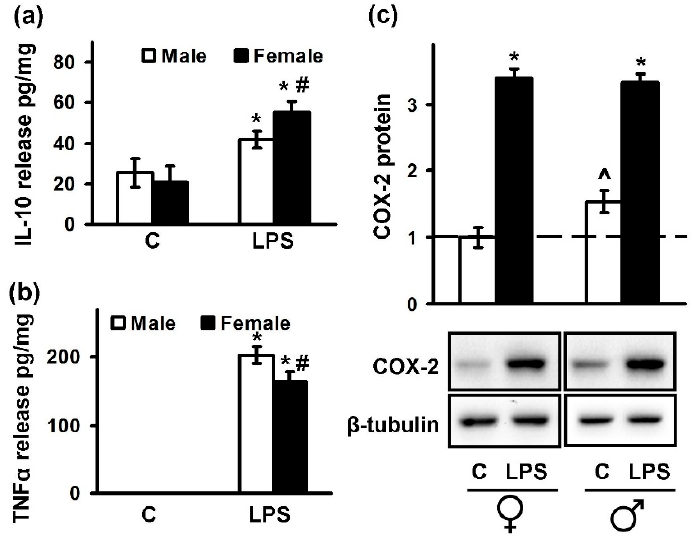
Figure 2. Sex differences in tumor necrosis factor alpha (TNF α ), cyclooxygenase (COX)-2, and interleukin-10 (IL-10) expression during acute inflammation. Male (white) and female (black) astrocytes cultures were kept for 4 h with lipopolysaccharide (LPS) (100 ng/mL), then the concentrations of IL-10 ( a ) and TNF α ( b ) were measured by ELISA in the supernatants samples. The results are represented as mean ± SEM from three independent experiments performed in triplicate. ( c ) COX-2 protein levels were measured by Western blotting. Equal protein loading was confirmed using a β -tubulin antibody. The blot is representative of three independent experiments. * p < 0.05 compared with unstimulated cells, # p < 0.05 compared with indicated bars (sex difference), ˆ p < 0.05 compared with male COX-2 basal protein levels.